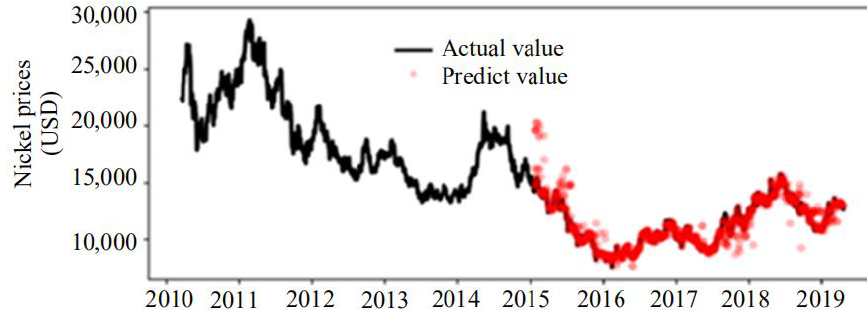
Figure 2. Comparison of predictive and actual copper price.